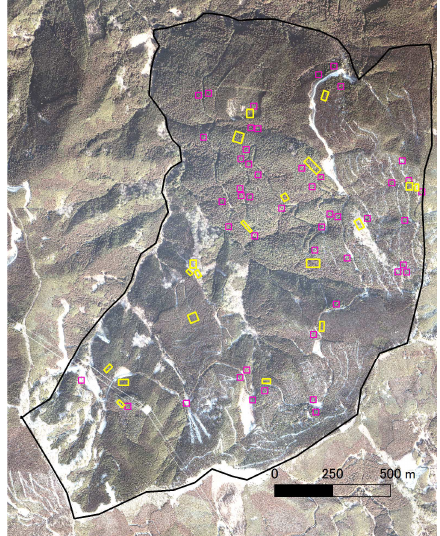
Figure. 4 Acquired dataset for the experiments plarform